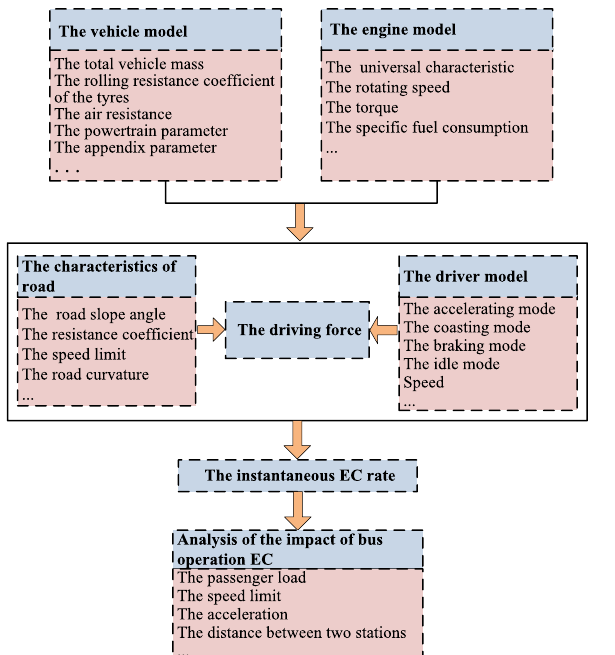
Figure 1. The simulation framework based on VEC